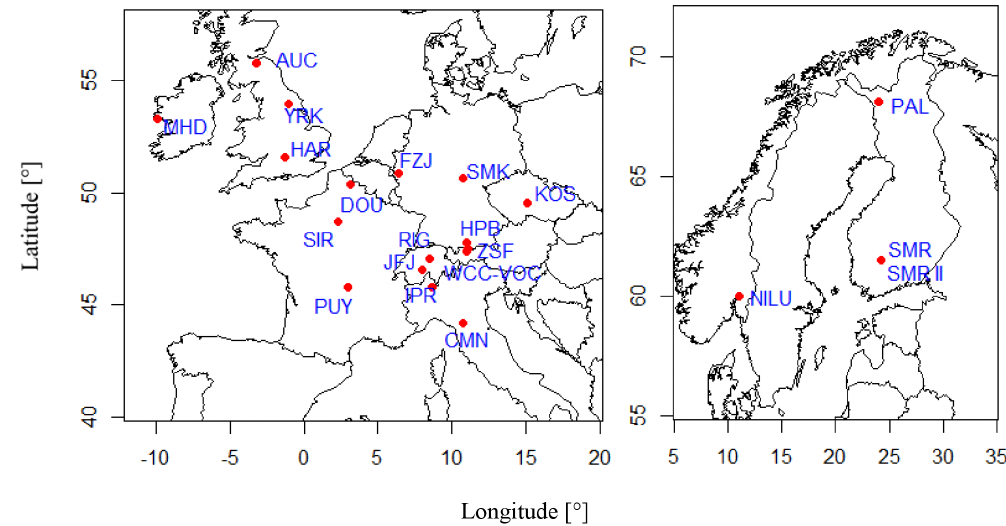
Figure 1. The participants of the ACTRIS NMHC intercomparison in Europe. Left: western, central, and southern Europe; right: north- ern Europe. AUC: Auchencorth, CMN: Monte Cimone; DOU: Mines des Douai; FZJ: Forschungszentrum Jülich; HAR: Harwell; HPB: Hohenpeissenberg; IPR: Ispra; JFJ: Jungfraujoch; KOS: Kosetice; MHD: Mace Head; NILU: Norwegian Institute for Air Research; PAL: Pallas; PUY: Puy-de-Dôme; RIG: Rigi; SIR: Sirta; SMR: GC-MS, and SMR II: PTR-MS (both at SMEAR II, Hyytiälä); SMK: Schmücke; WCC-VOC: Garmisch-Partenkirchen; YRK: York; ZSF: Zugspitze-Schneefernerhaus. For further details about the stations and instruments see Table